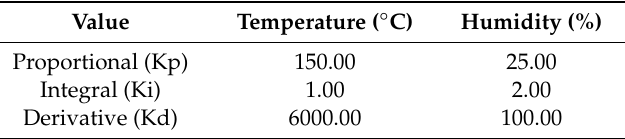
Table 5. PID values